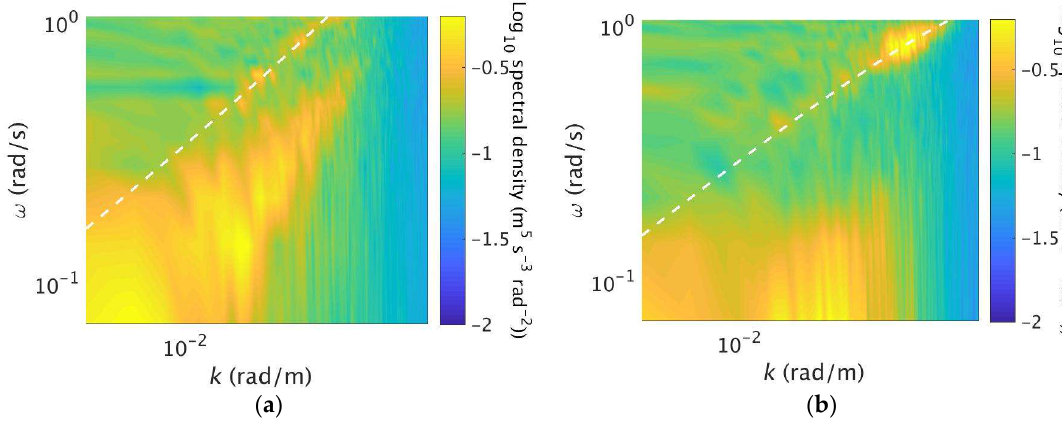
Figure 2. ( a ) k - ω Doppler velocity spectrum for dataset 1; ( b ) k - ω Doppler velocity spectrum for dataset 2. The white dashed line in both panels shows the linear dispersion relationship (adjusted for currents and ship forward speed).